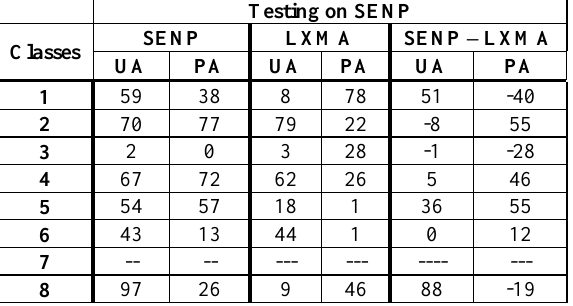
Table 7 User’s and Producer’s accuracy for each of the classes, considering each of the training datasets, LXMA and SENP; tested only on the SENP dataset.